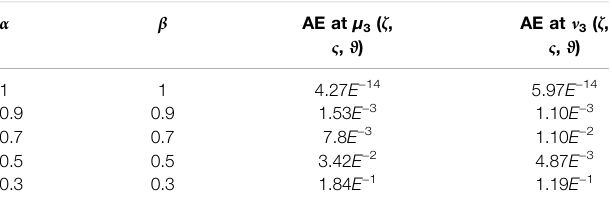
TABLE 2 | AE of ETDM at various values of α and β